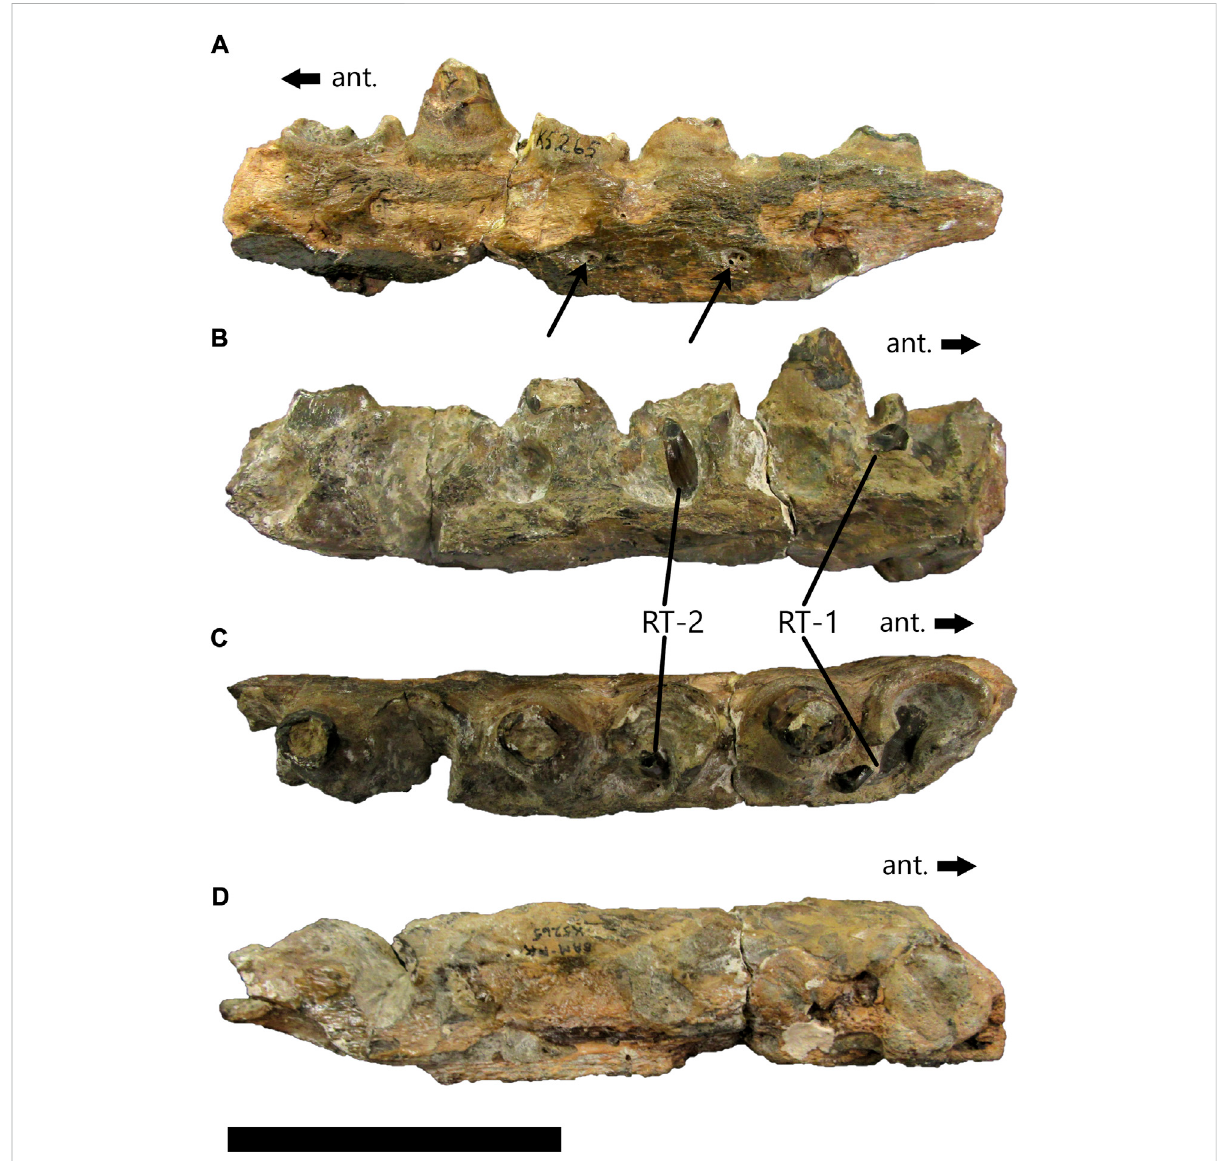
FIGURE 9 Anterior dentary fragment, cf. Taniwhasaurus (SAM-PK-5265) in lateral (A) , medial (B) , dorsal (C) and ventral (D) view. Thin black arrows in (A) indicate large foramina. Two replacement teeth are indicated in (B) and (C) . Directional arrows show anterior end of fragment. Scale bar = 100